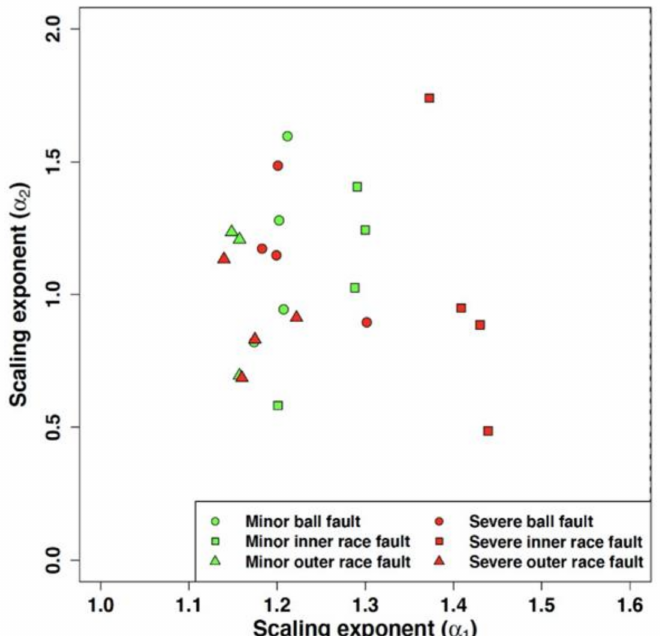
Figure 10. Scaling exponents of bearing vibration signals (12,000 samples/s) at short- and long- time scales.